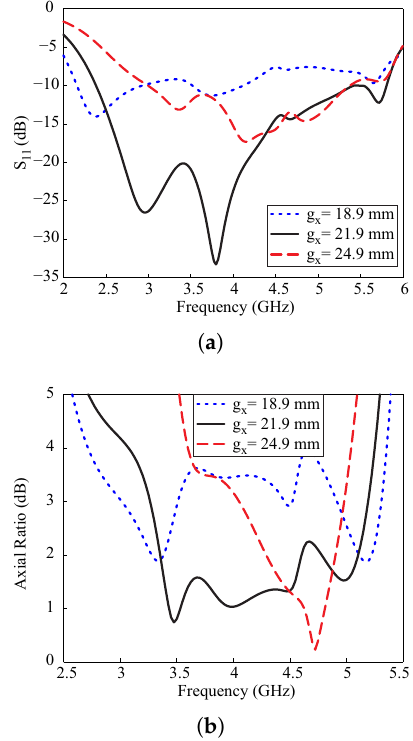
Figure 4. Effect of the variation of the ground plane width g